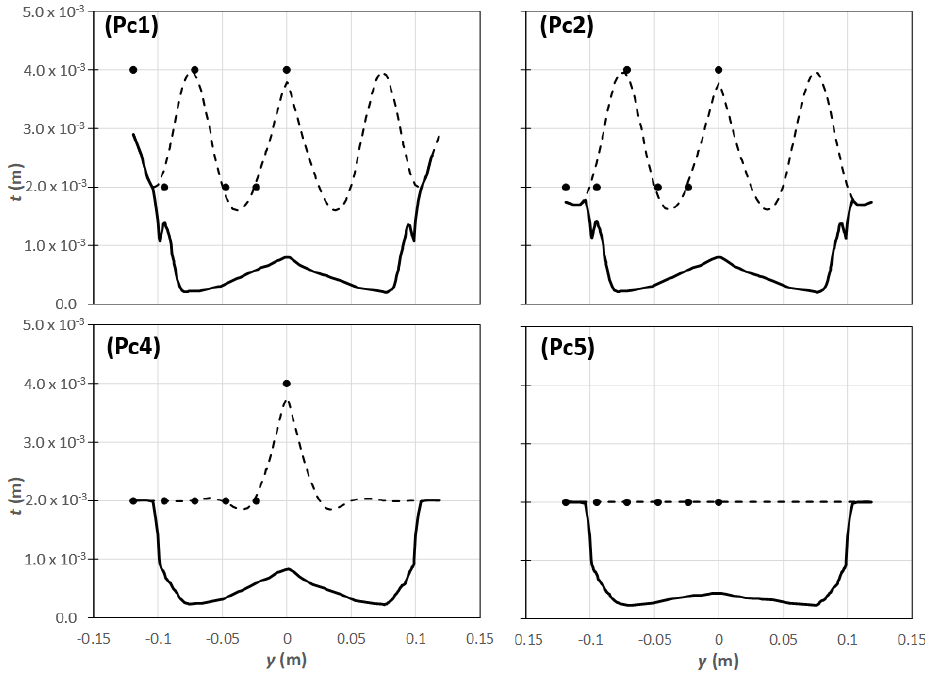
Figure 13. Thickness profile for solutions Pc1, Pc2, Pc4 and Pc5 (Figure 9): black points are the decision variables, dashed line is the concentric spline and the continuous line the part thickness profile a x = 0.